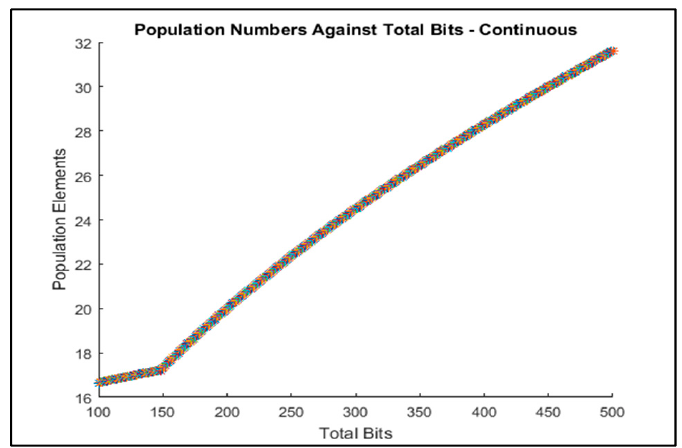
Figure 1. Growth of population size requirement with increasing chromosome bit size.